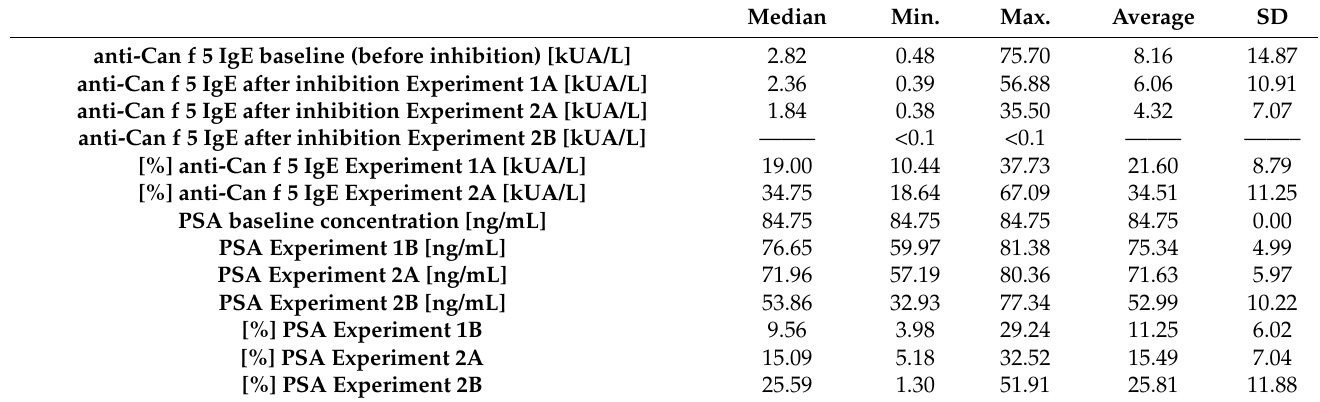
Table 2. The average results of both models of inhibition